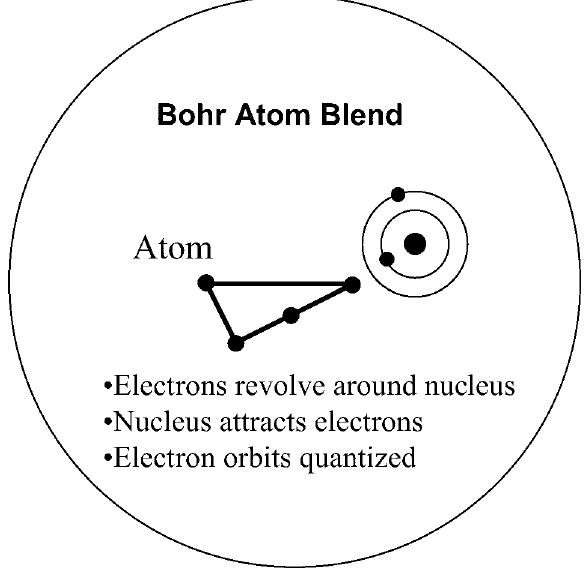
FIG. 5. Adding quantization produces the Bohr atom blend. The additional node between sign and schema represents a blend which incorporates quantization into the schema linked to this